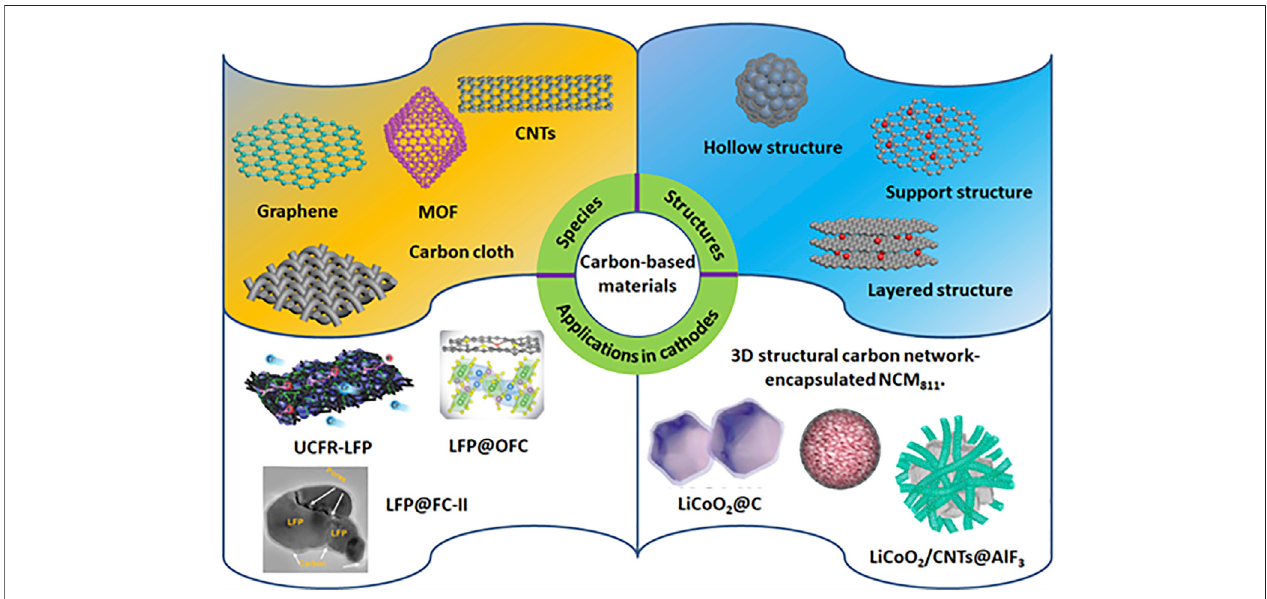
FIGURE 1 | Schematic diagram of carbon-based materials in addressing the challenges of LIBs in different cathodes. Reprinted with permission from Li H. et al. (2019) with permission from WILEY-VCH. Reprinted with permission from Lin J. et al. (2022), Wang X. et al. (2019), and Hwang. et al. (2020) with permission from Elsevier. Reprinted with permission from Lin J. et al. (2020) with permission from The Royal Society of Chemistry. Reprinted with permission from Cheng Q. et al. (2019) with permission from the American Chemical Society.